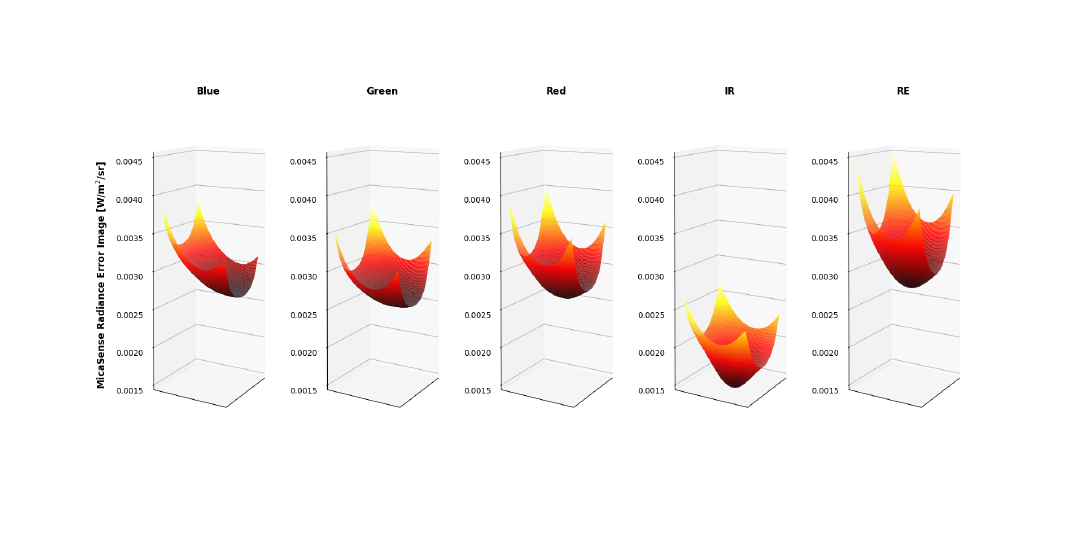
Figure 25. Example error of MicaSense radiance imagery. Only gain, exposure time and image error components are present in these errors. Noticeable vignette shape is seen in all